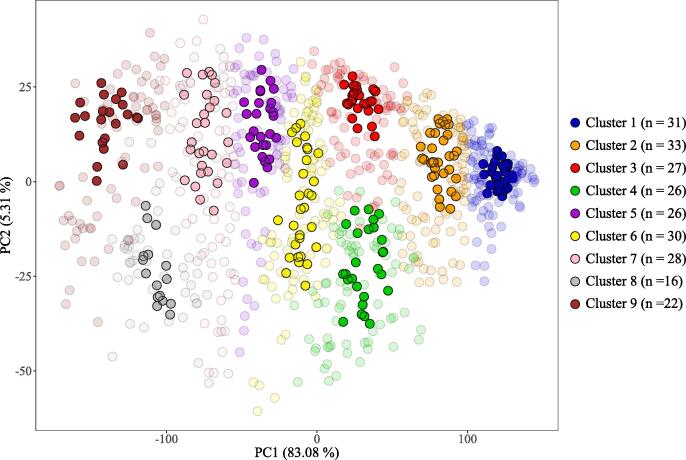
Principal component scores of pre-treated X-ray power diffraction data and the resulting clusters defined by the fuzzy-c-means algorithm. Total number of samples =935. Samples excluded from subsequent analysis are plotted as translucent symbols, whilst those retained are plotted as opaque symbols.